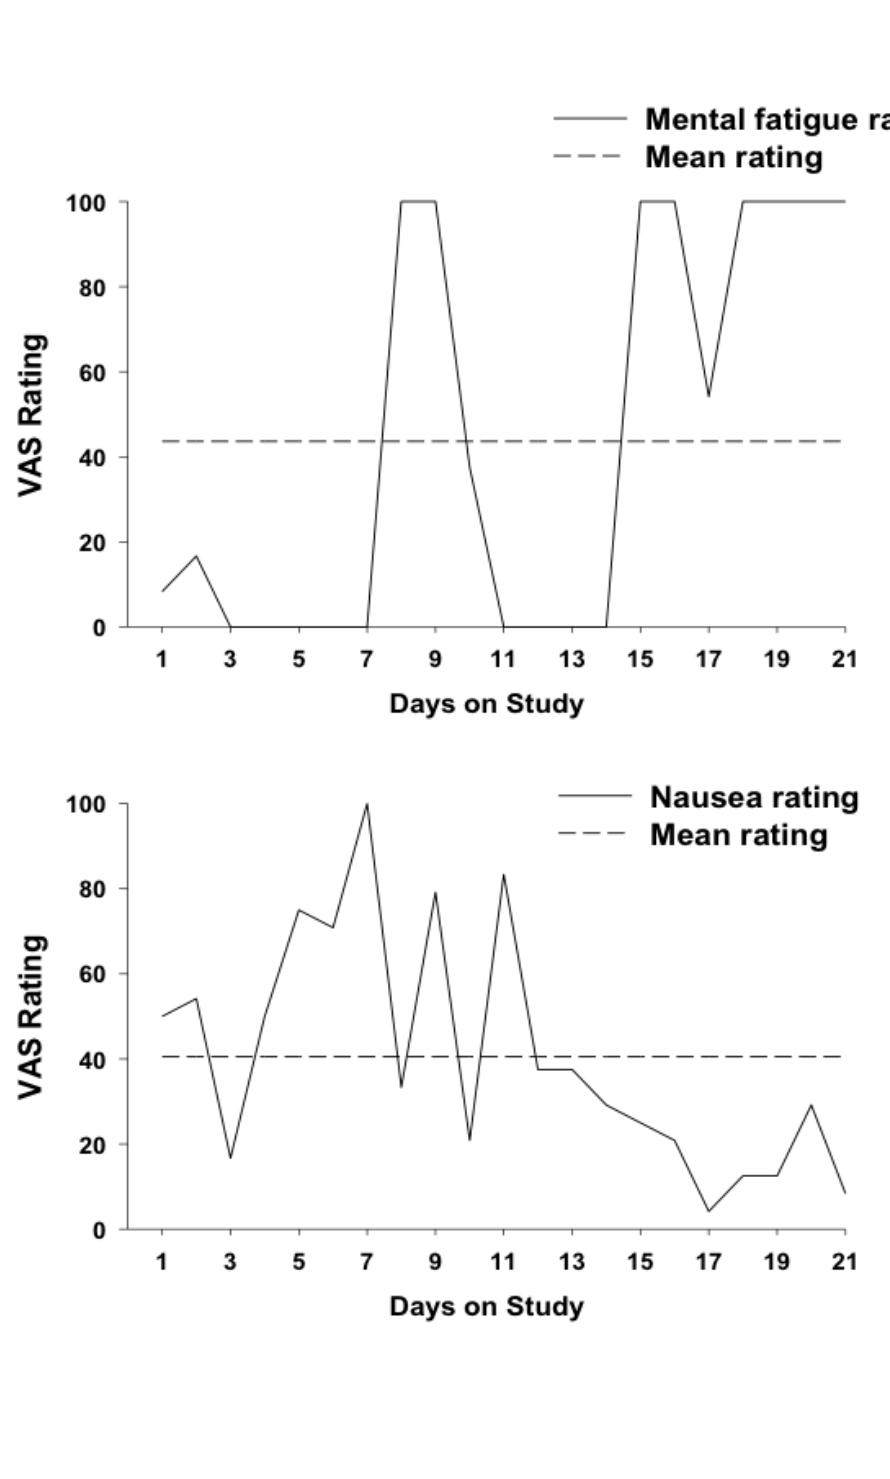
Figure 1. Mental fatigue and nausea ratings for participant 5. Mental fatigue rating in response to the statement “My mind has felt worn out” on a 0-100 VAS, where higher values indicate more severe fatigue. Nausea rating is response to nausea query on a 0-100 VAS, where higher values indicate more severe nausea. Dashed line represents mean values over the 21-day study